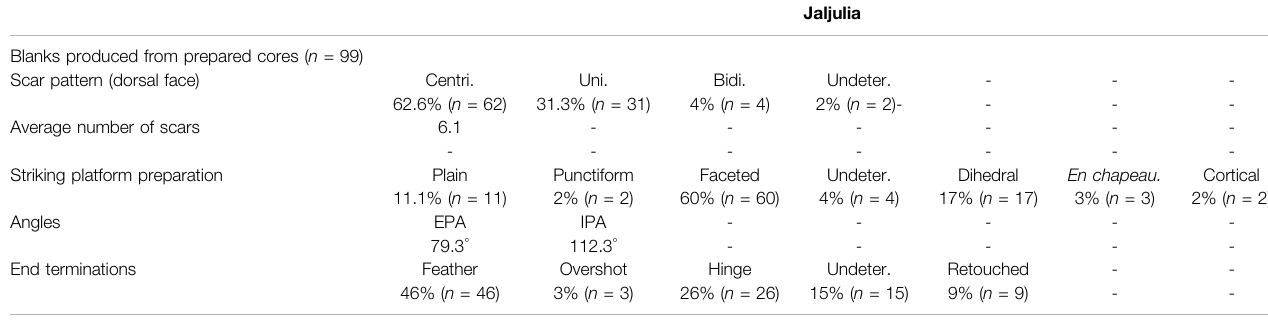
TABLE 6 | Major attributes of blanks produced from prepared cores, from Jaljulia. Prefer. (Preferential); Rec. (Recurrent); Centri. (centripetal); Uni. (unidirectional); Bidi. (bidirectional); Undeter. (Undetermined); En chapeau. ( En chapeau de gendarme ).